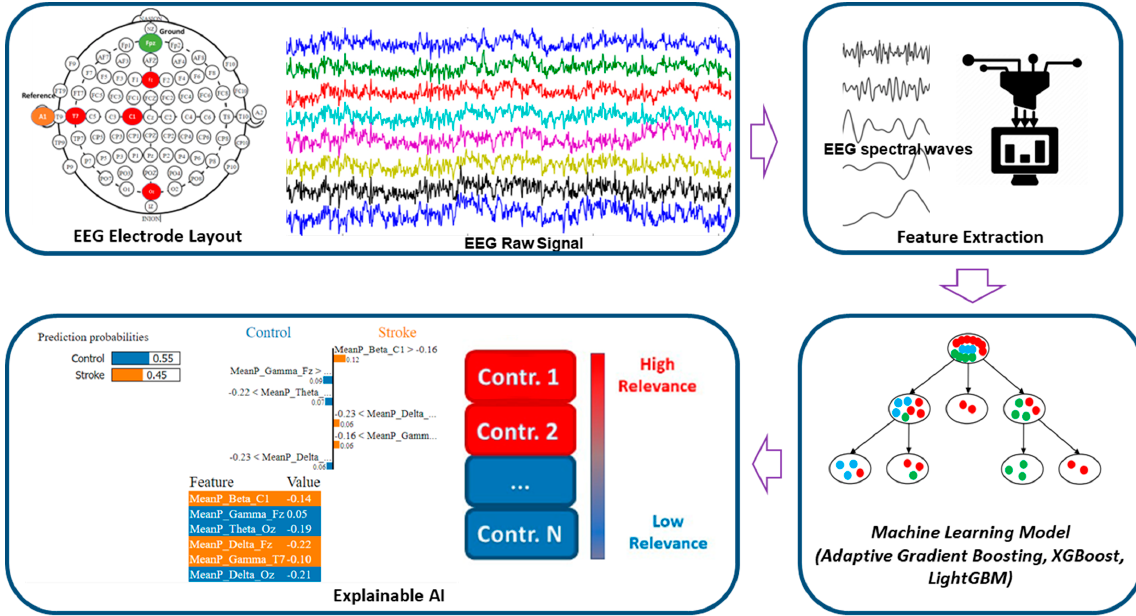
Figure 1. Overview of EEG-based stroke diagnostics using the explainable machine-learning ap- proach.